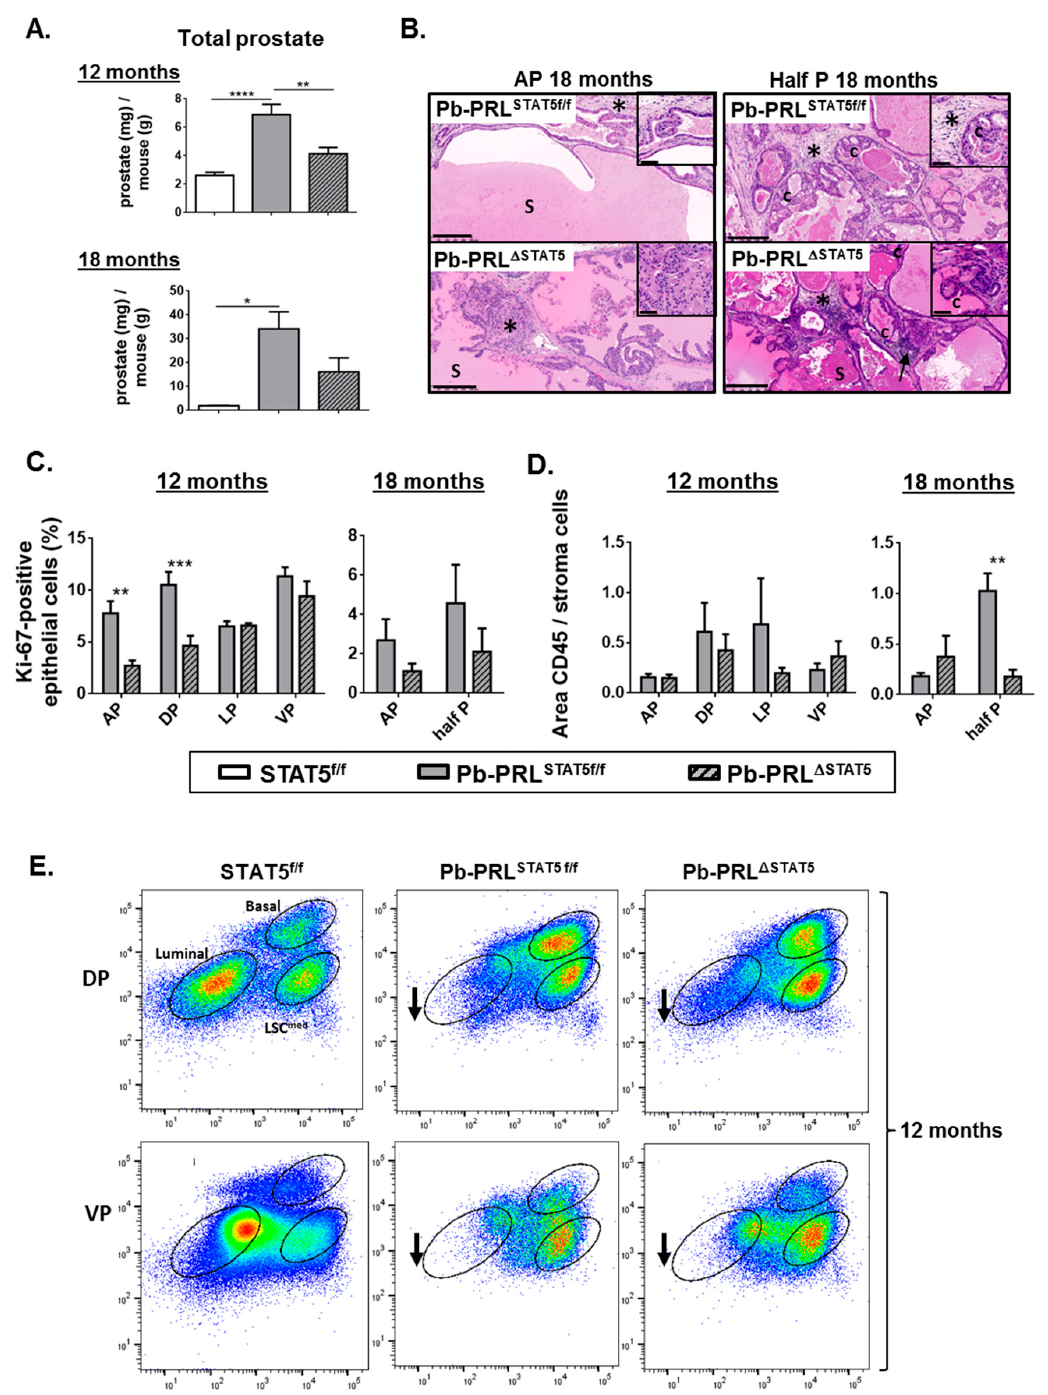
Figure 5. STAT5 deletion does not prevent prostate tumor progression in aged Pb-PRL mice. ( A ). The prostate weight in 12 and 18 month-old STAT5 f / f , Pb-PRL STAT5f / f and Pb-PRL ∆ STAT5 mice is expressed as the ratio of total prostate weight normalized to the weight of corresponding animal (see Figure S5A for data per lobe). ( B ). Histological analysis (hematoxylin counterstaining) of prostate tumors of 18 month-old Pb-PRL STAT5f / f and Pb-PRL ∆ STAT5 mice showing similar abnormal histology including PINs, cribriform lesions (“c”), increased stromal density (stars), inflammation (arrows), and dense eosinophilic secretions (S). Sections from the anterior lobe (AP) and from fused dorsal / lateral / ventral lobes are shown. See Figure S5B for 12 month-old animals. ( C ). The proliferation index in prostates from 12 (all lobes) and 18 month old (anterior lobe and total prostate) mice is shown (see Figure 2 for details). ( D ). Inflammation was identified using CD45 immunostaining. The degree of inflammation